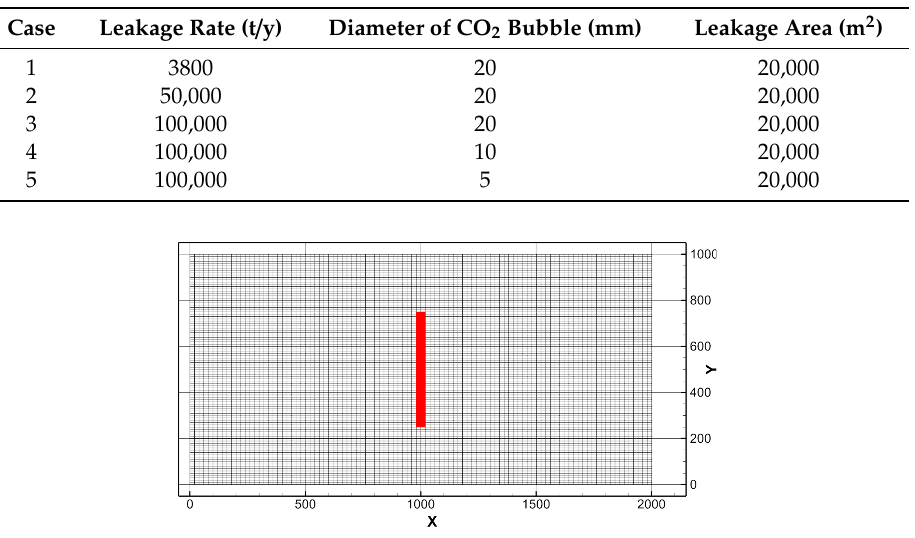
Figure 4. Distribution of leakage area at the bottom surface of the small-scale domain, of which the horizontal grid sizes are 20 m × 10 m.